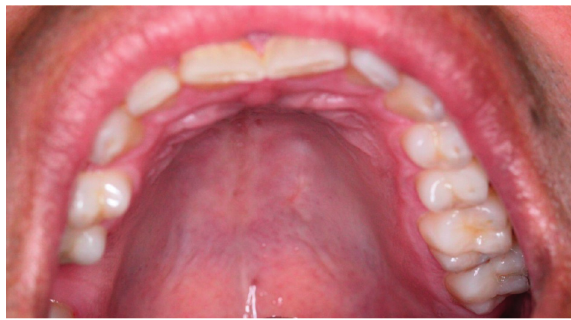
Figure 4: Surgical wound 4 months after